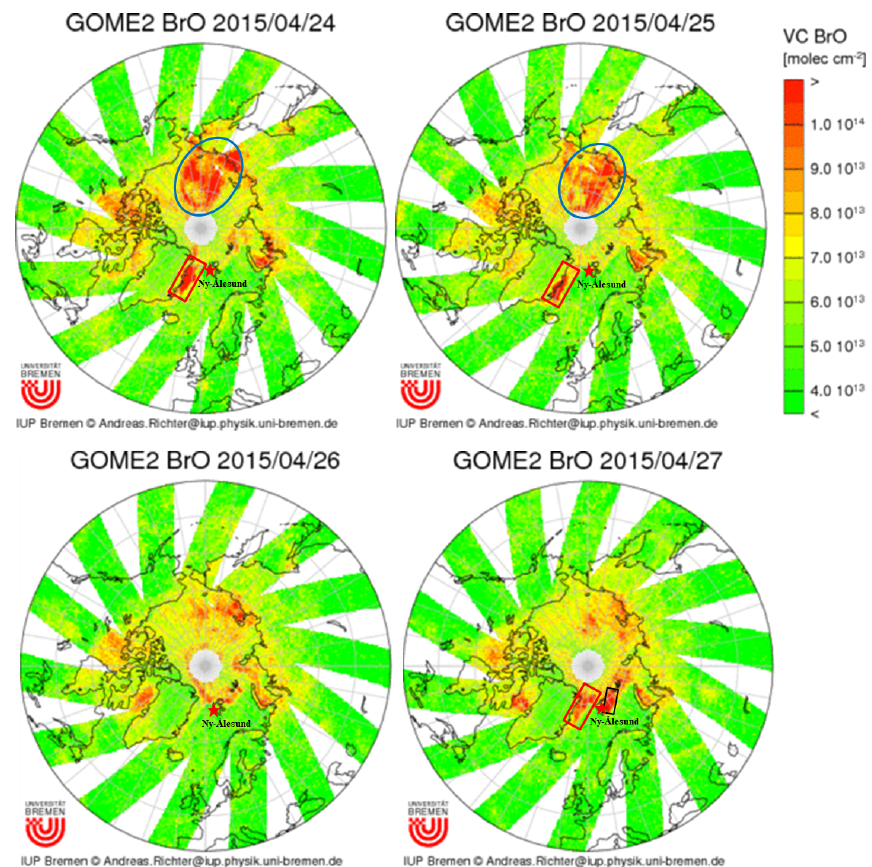
Figure 10. Map of tropospheric BrO of the Northern Hemisphere by GOME-2 products from 24 April to 27 April. (cited from http://www. iup.uni-bremen.de/doas/scia_data_browser.htm, last access: 9 July